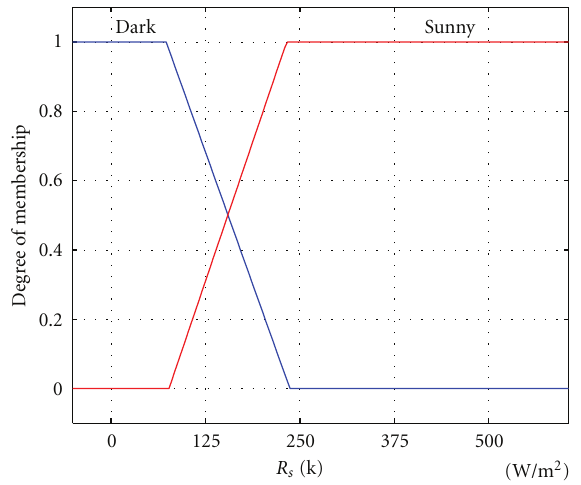
Figure 8: Membership function of the intercepted solar radiation.